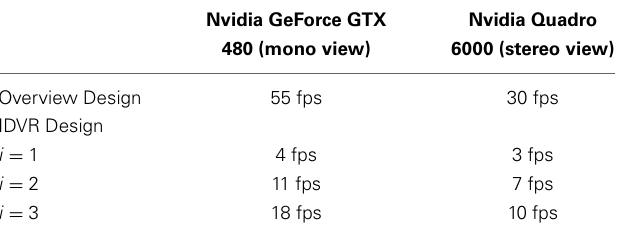
Table 1 | Results of performance tests of the visualization designs (averaged values from different view points), the overview design with common volume rendering and the IDVR design with different precision states for the cutout